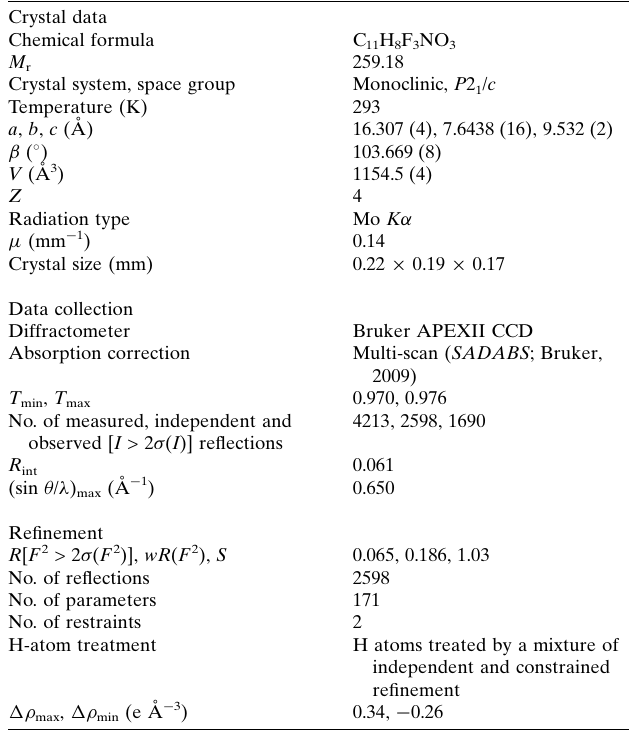
Table 2 Experimental